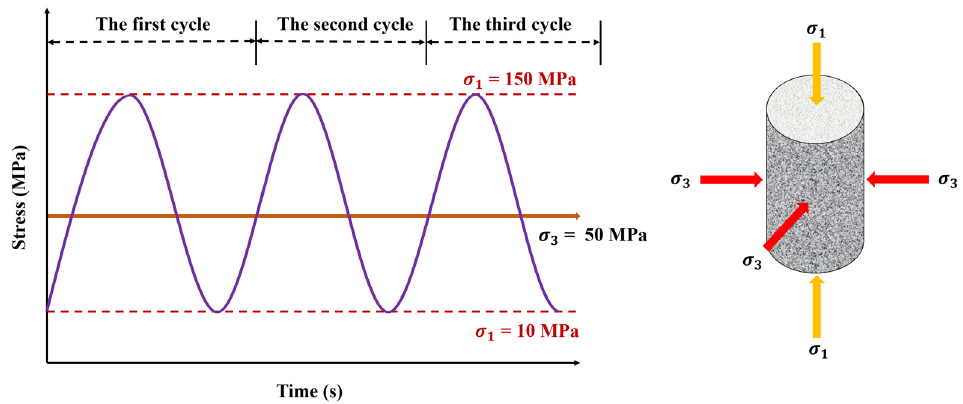
Figure 2. Cyclic loading scheme.